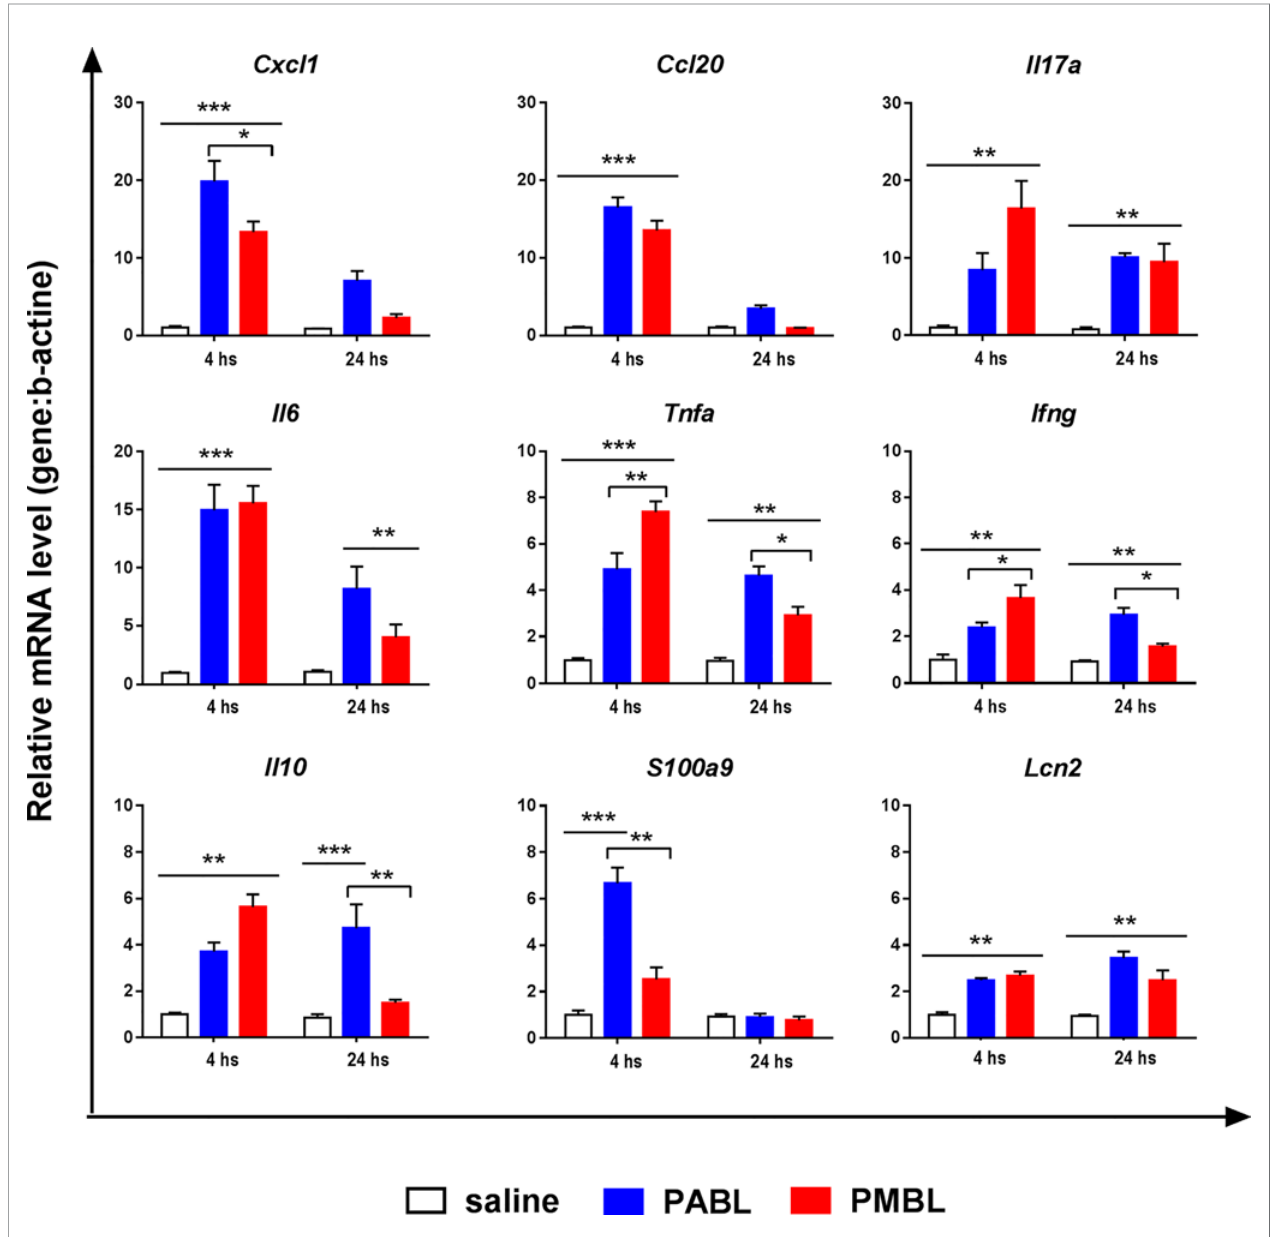
FIGURE 4 | Pro-in fl ammatory response induced in the lungs of mice treated with either PABL or PMBL. Mice received i.n. PABL or PMBL (6 µg/30 µl) or saline, and lungs were obtained 4 or 24 hours later. Relative mRNA levels for Cxcl1, Ccl20, Il17a, Il6, Tnfa, Inf g , Il10, S100a9 and Lipocalin 2 were assessed by RT-qPCRs. Data is expressed as fold increase of relative mRNA levels of each gene normalized against b-actin referred to non-stimulated cultures. Each point represents Mean ± SEM of quintuplicate cultures. Signi fi cant differences between groups are indicated by *p < 0.05, **p < 0.005 and ***p < 0.0001, one-way ANOVA. Data are representative of three independent